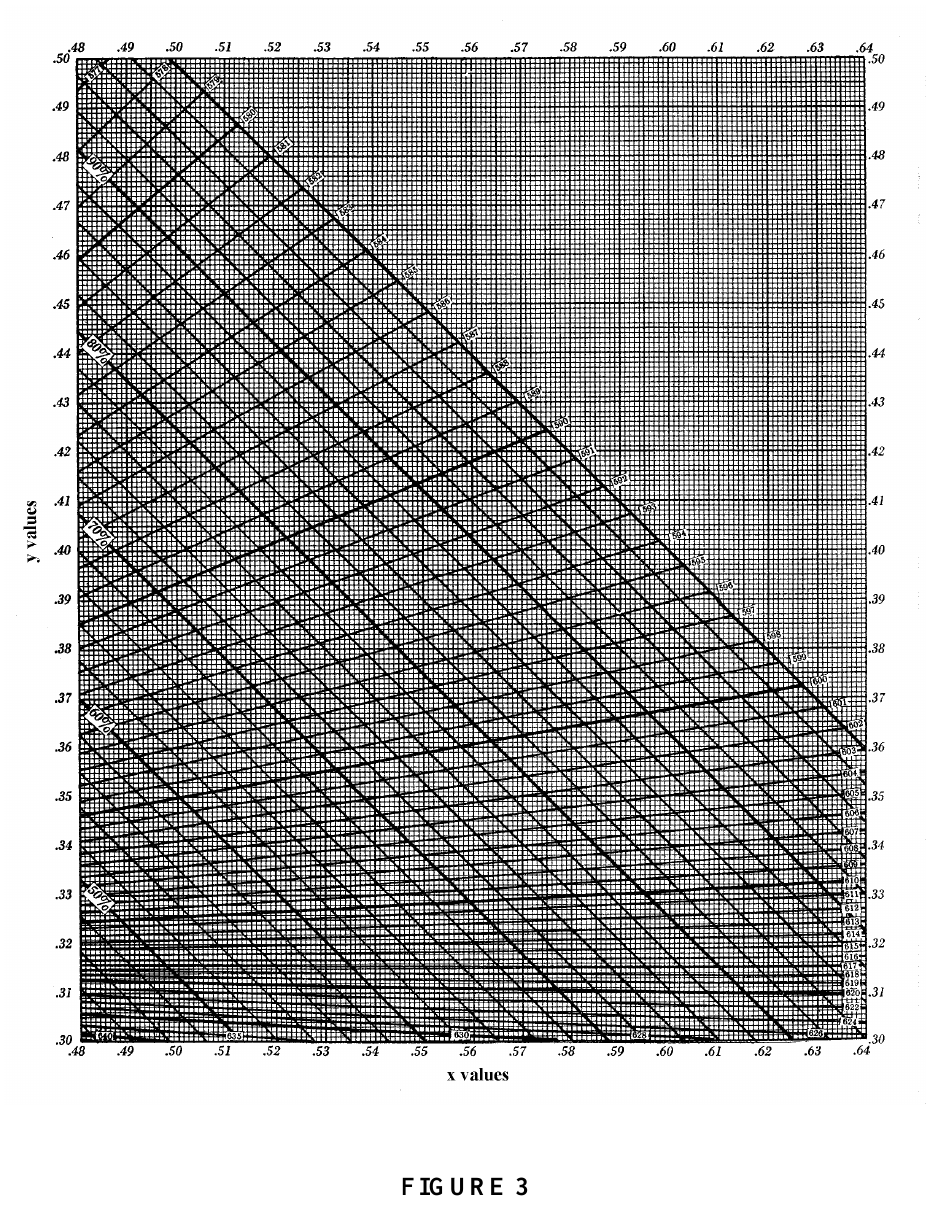
Chromaticity diagram for pure red wines and brick red